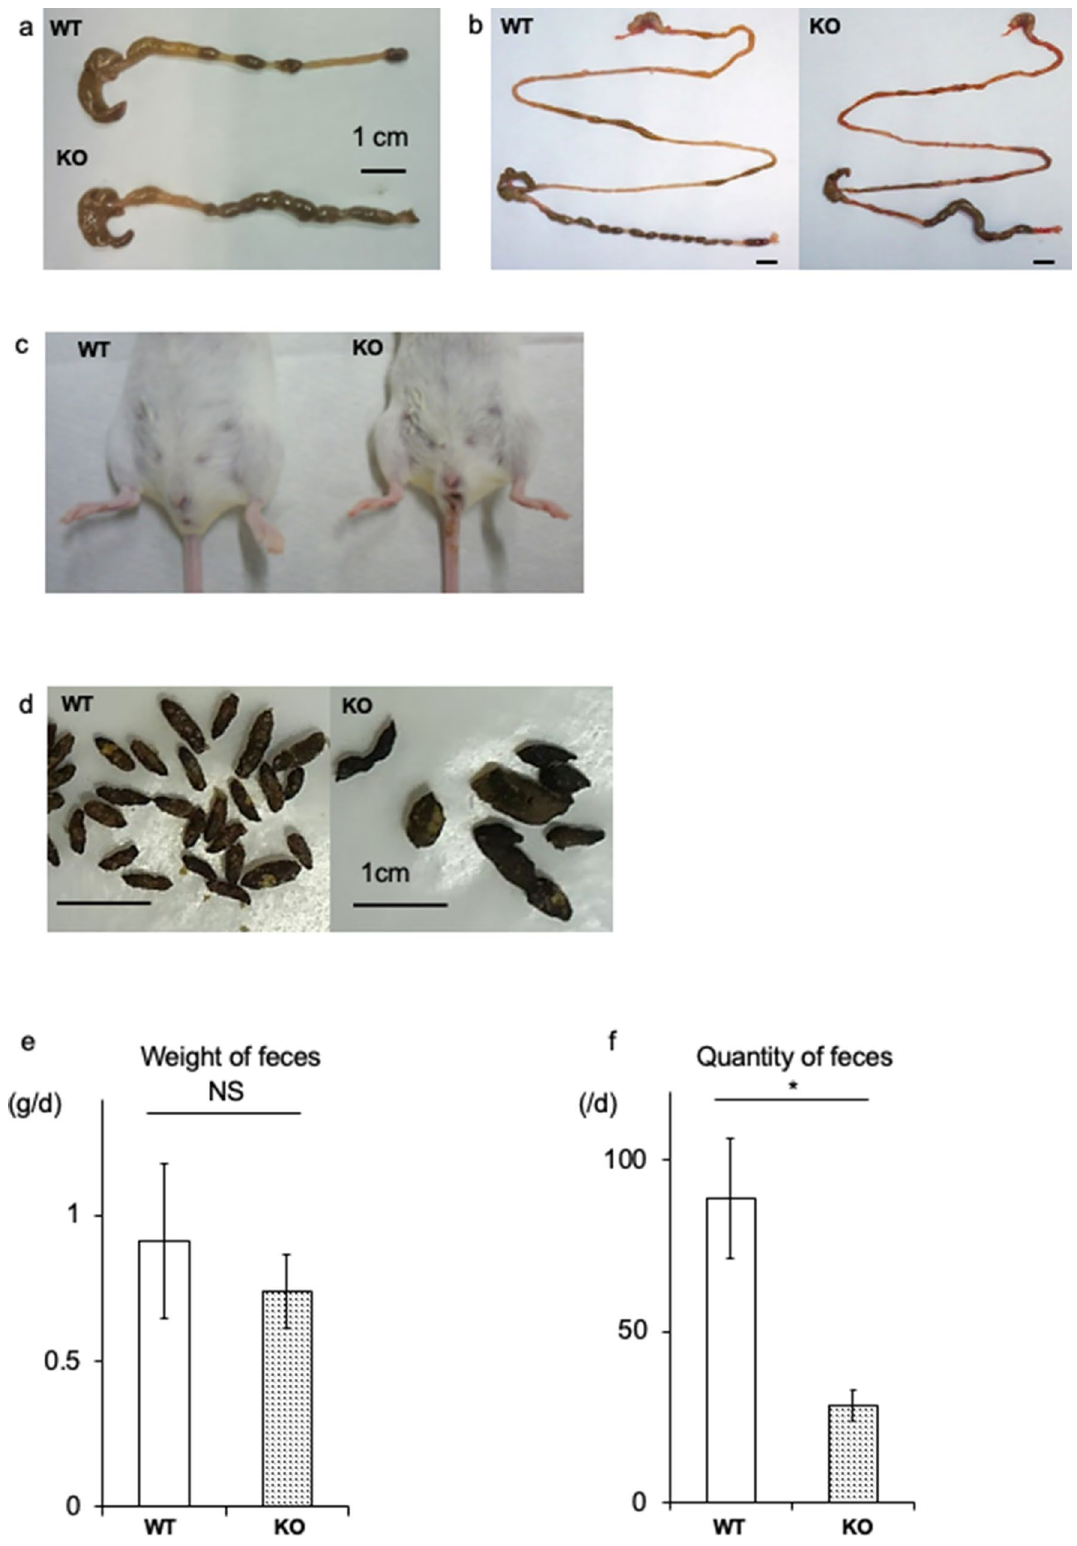
Figure 2. Functional analysis of the gastrointestinal (GI) tract. ( a ) Large intestine dissected from WT and KO littermates at 20 days. ( b ) Entire GI tract dissected from WT and KO mice. Note the delayed stool located in the middle segment of the large intestine in the KO mouse. ( c ) Anal region of WT and KO mice with watery stool attached around the anus in the KO mouse. ( d ) Fecal characterization. Feces of WT mice are large in number and similar in size. In contrast, feces of KO mice are small in number and irregular in size. ( e , f ) Comparison of the weight and quantity of daily feces. Total fecal weight expelled by KO mice is similar; however, the quantity is significantly less than observed in WT mice. This corresponds to higher weight per grain of feces. *P < 0.05, NS not